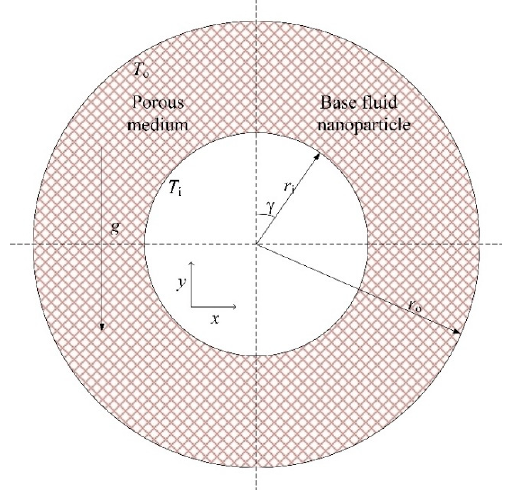
Figure 1. Sketch of problem geometry.